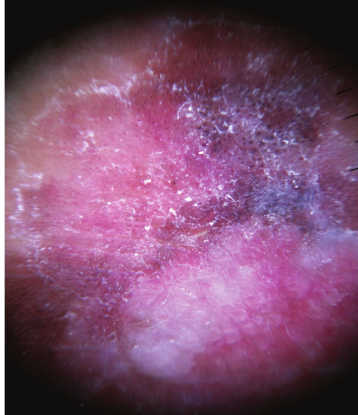
Figure 8: Dermoscopy in Case 2 shows structureless brown and blue-gray peripheral pigmentation with keratosis, patches of brown regular globules in clustered a linear arrangement, clusters of glomerular vessels in a linear arrangement, keratin globules (“cotton candy” keratosis) scattered throughout the lesion, as well as a linear keratinous rim.